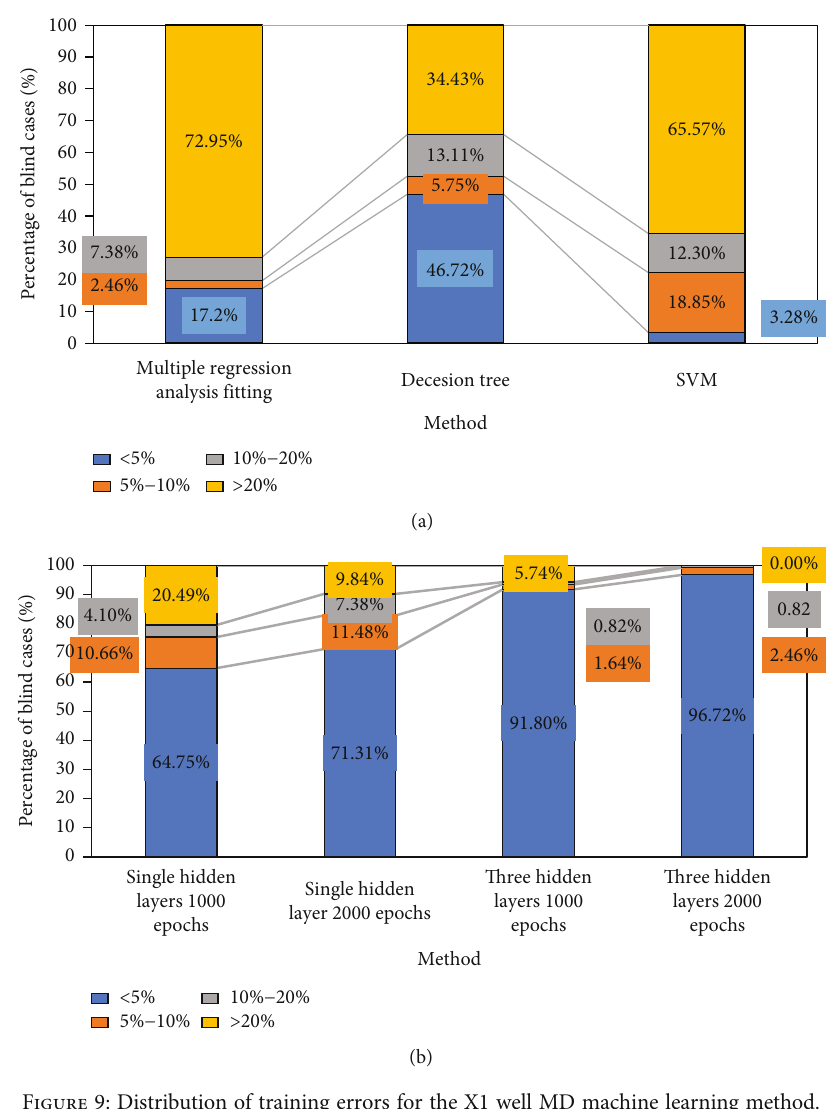
Figure 9: Distribution of training errors for the X1 well MD machine learning